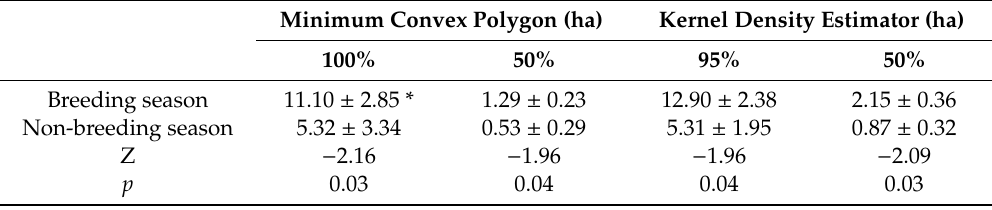
Table 4. Di ff erences in the home range and core area of Siberian flying squirrels between breeding and non-breeding seasons at Mt. Baekwoon, Gangwon Province, South Korea.